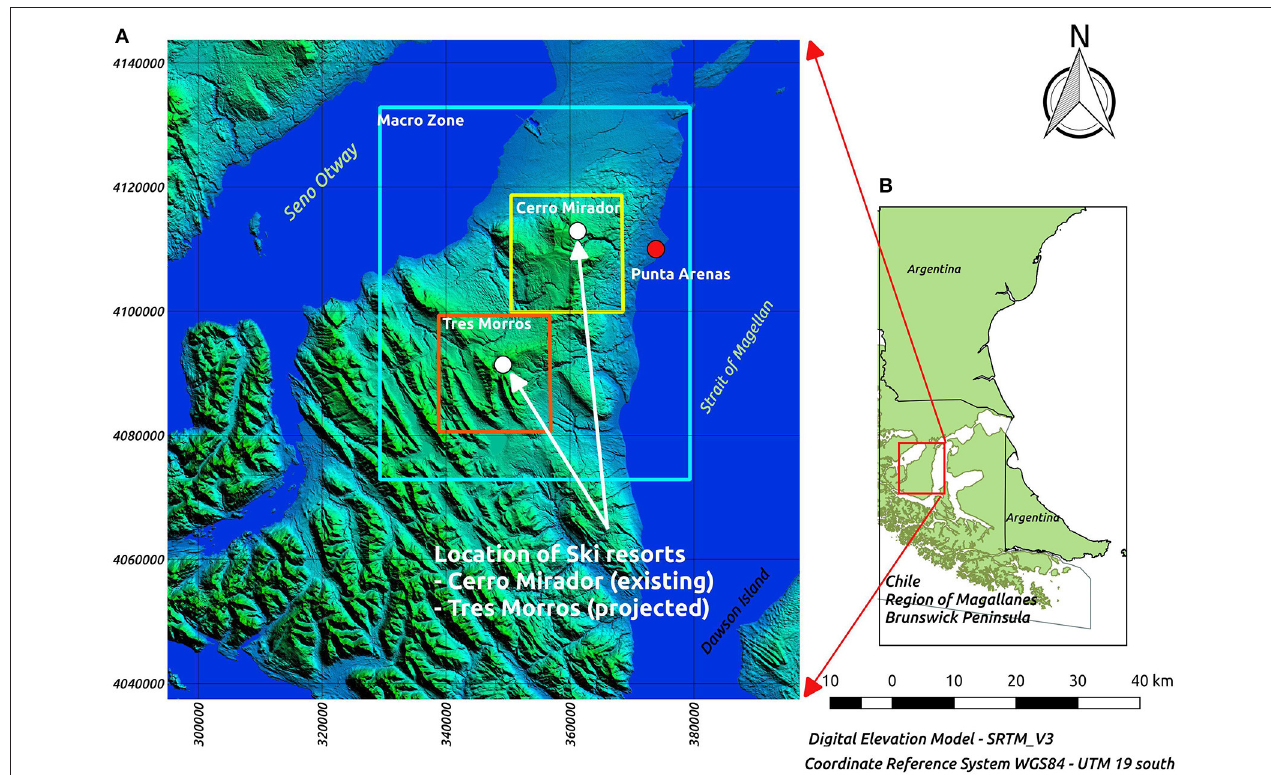
FIGURE 1 | General view of the study area. (A) shows the Brunswick Peninsula with the three study zones: Macro zone of 1637 km 2 (cyan), Cerro Mirador of 302 km 2 (yellow), and Tres Morros of 291 km 2 (red). The terrain elevation is shown with a DEM from SRTM_V3 data. (B) presents the general location of the study